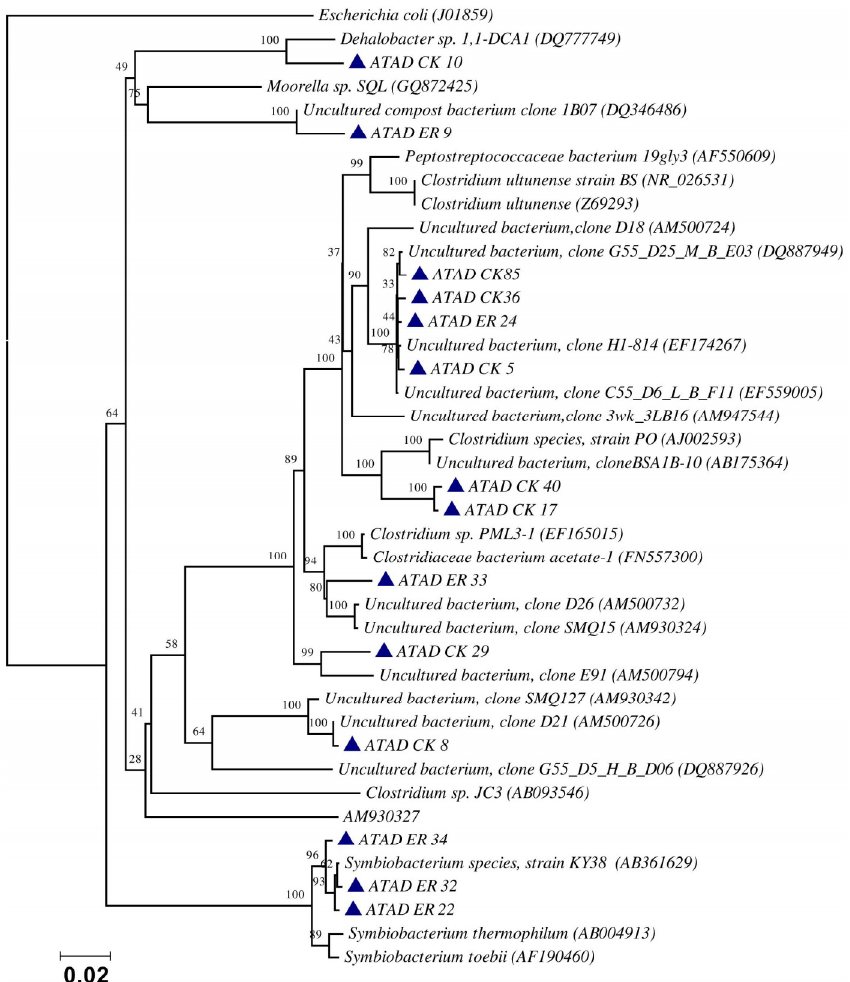
Figure 1. Evolutionary relationship of the ATAD clones and their closest neighbors shown as a phylogenetic tree among the Firmicutes, class Clostridia and relatives of the domain Bacteria derived by neighbor-joining analysis of 16S rDNA sequences. The bootstrap consensus tree inferred from 1000 replicates is taken to represent the evolutionary history of the taxa analyzed [51]. The percentage of replicate trees in which the associated taxa clustered together in the bootstrap test (1000 replicates) are shown above the branches. The evolutionary distances were computed using the maximum composite likelihood method and are in the units of the number of base substitutions per site. There were a total of 1238 positions in the final dataset. Phylogenetic analyses were conducted in MEGA 4.0 [52]. Reproduced with permission from Water Research, Elsevier.